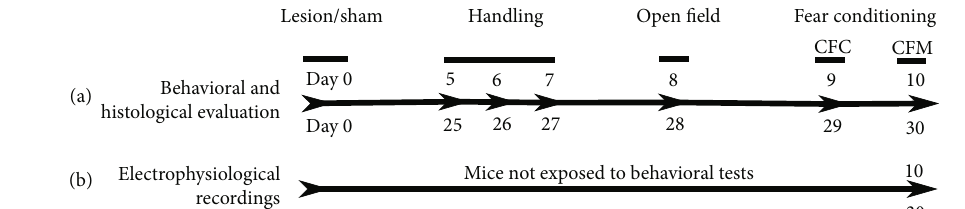
Figure 1: Experimental design. Kainic acid injections or sham surgeries were performed on day 0. Mice were handled and habituated to the experimenter for three consecutive days before the onset of behavioral procedures. On days 8 or 28 after surgery, mice performed the open fi eld task. The next day (day 9 or 29), mice underwent contextual fear conditioning (CFC), and 24 h later, contextual fear memory (CFM) was evaluated. After memory retrieval, subjects were sacri fi ced and brains were extracted for histological analysis. A di ff erent group of animals, not exposed to behavioral evaluation, was used for in vivo LTP